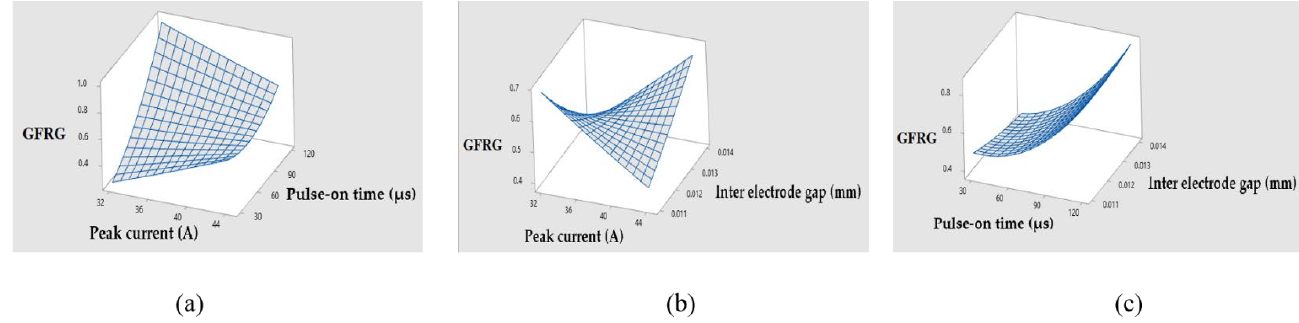
Figure 12. Surface plots of GFRG values w.r.t. process parameters. ( a ) GFRG vs. I, T on . ( b ) GFRG vs. I, IEG. ( c ) GFRG vs. T on , IEG. Table 10. ANOVA results obtained for corresponding GFRG values.